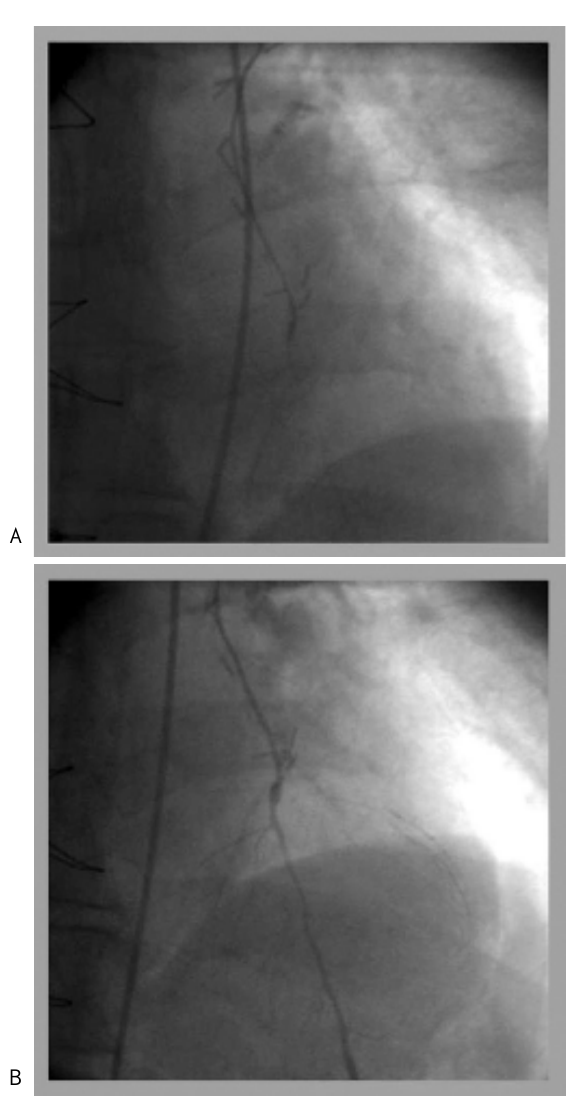
Fig. 2A (em cima)- DA com espasmo. Contraste injetado pela artéria torácica interna